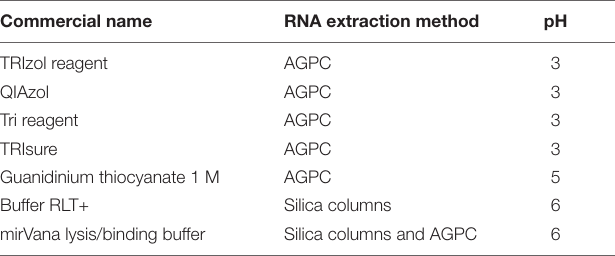
TABLE 1 | pH of commercially available lysis solutions for RNA